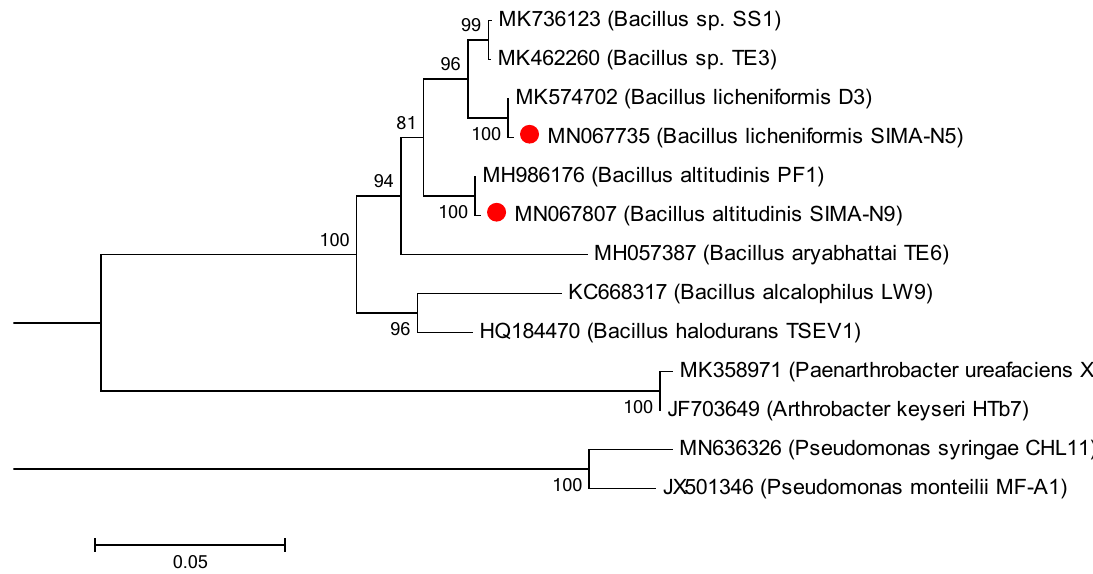
Figure 2. Phylogenetic tree of strain SIMA-N5 and